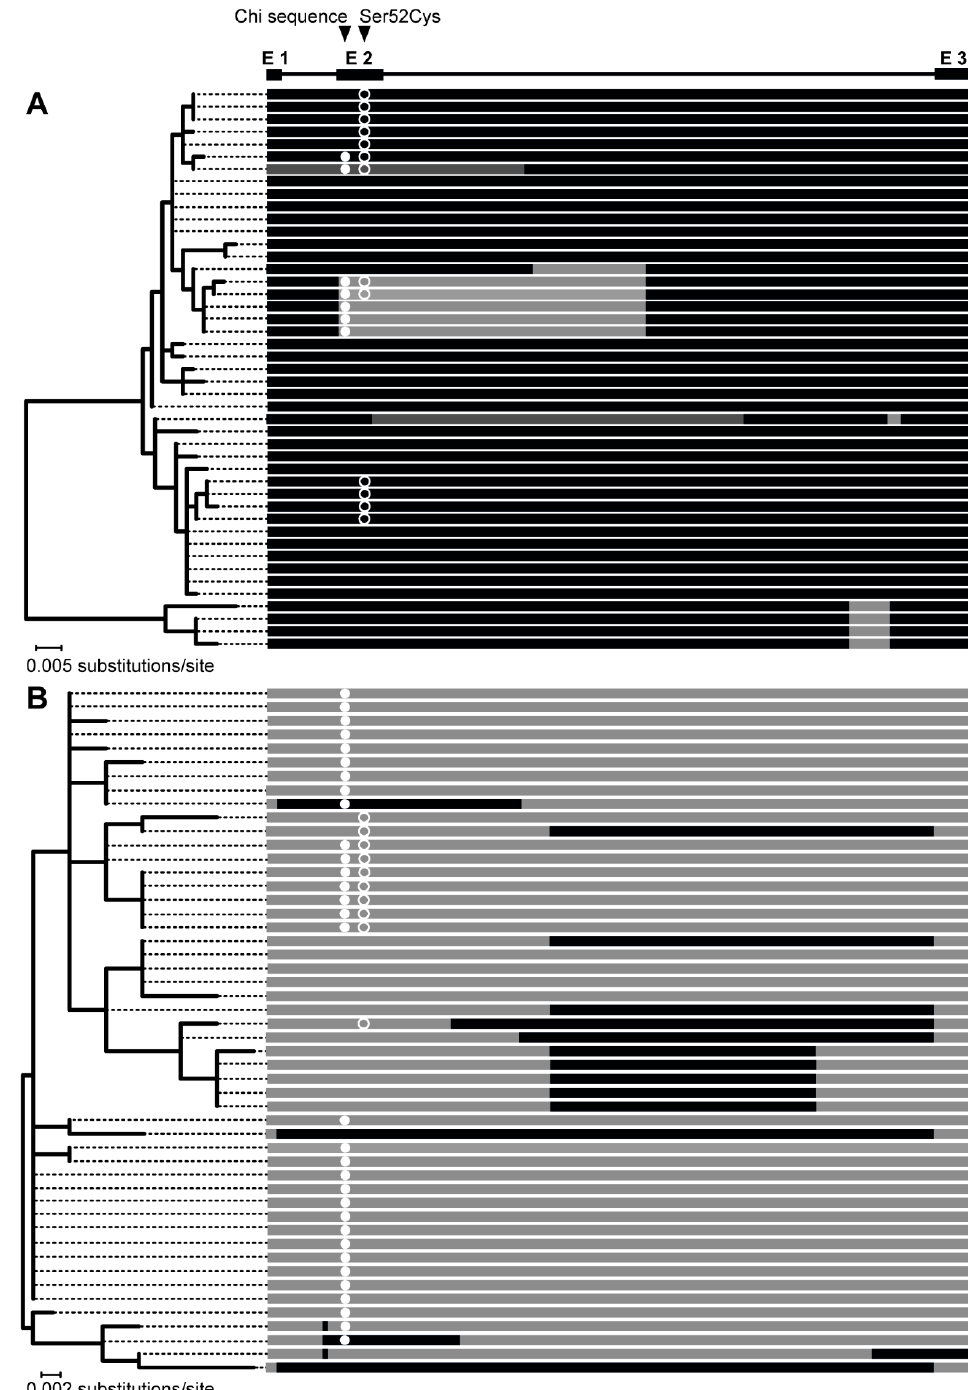
Figure 3. Maximum likelihood (ML) phylogenies based on the HBB-T1 ( A ) and HBB-T2 ( B ) alignments to the left of the recombination breakpoints identified by SBP. Haplotypes are represented by whole gene sequences with mapped conversion tracts. In HBB-T1, tracts identified by the method of Betrán et al. [56] are in light grey, tracts identified by GENECONV are in dark grey. The locations of the β-globin polymorphic site 52 and of the Chi sequence (see Section 4.2.) are depicted by arrows. Exons are marked by rectangles above the alignment.